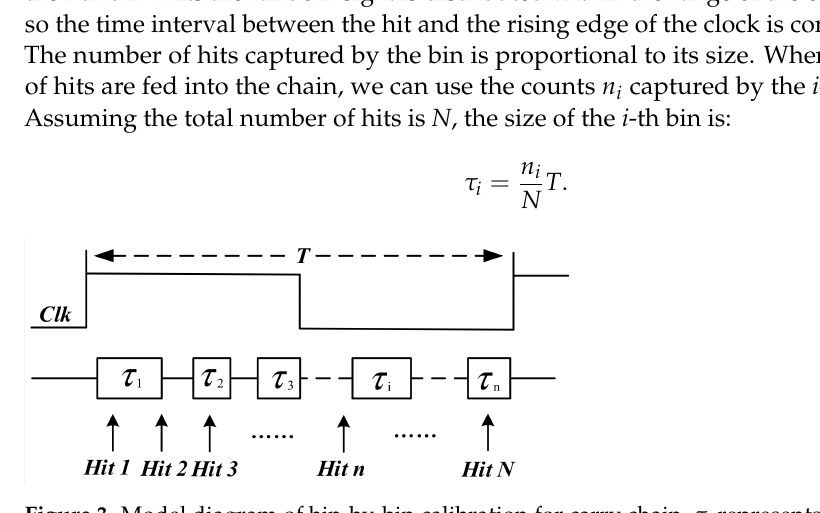
Figure 3. Model diagram of bin-by-bin calibration for carry chain. τ i represents the size of the i -th bin. Hit n is the random calibration signal distributed within the range of one clock period.